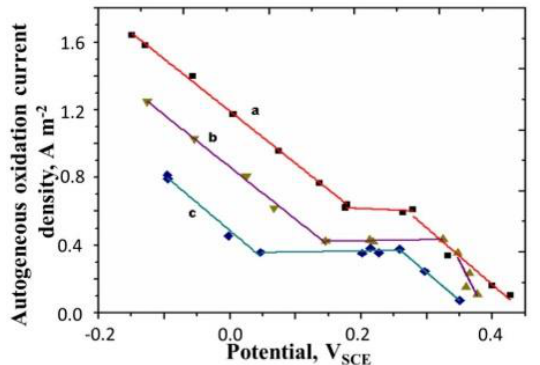
Figure 7. Polyaniline oxidation current density vs. potential plot. Concentration of H 2 SO 4 = 0.5M, Temperature = 25 °C. All potentials are with respect to SCE. Surface mass densities of polyaniline are-curve a: 0. 645 g m −2 ; curve b: 6.92 g m −2 ; curve c: 16.4 g m −2 .